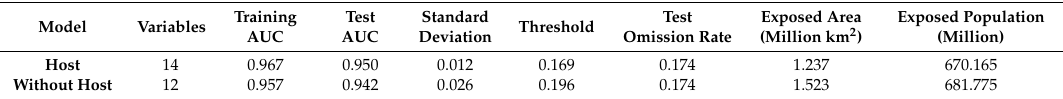
Table 2. Model evaluation